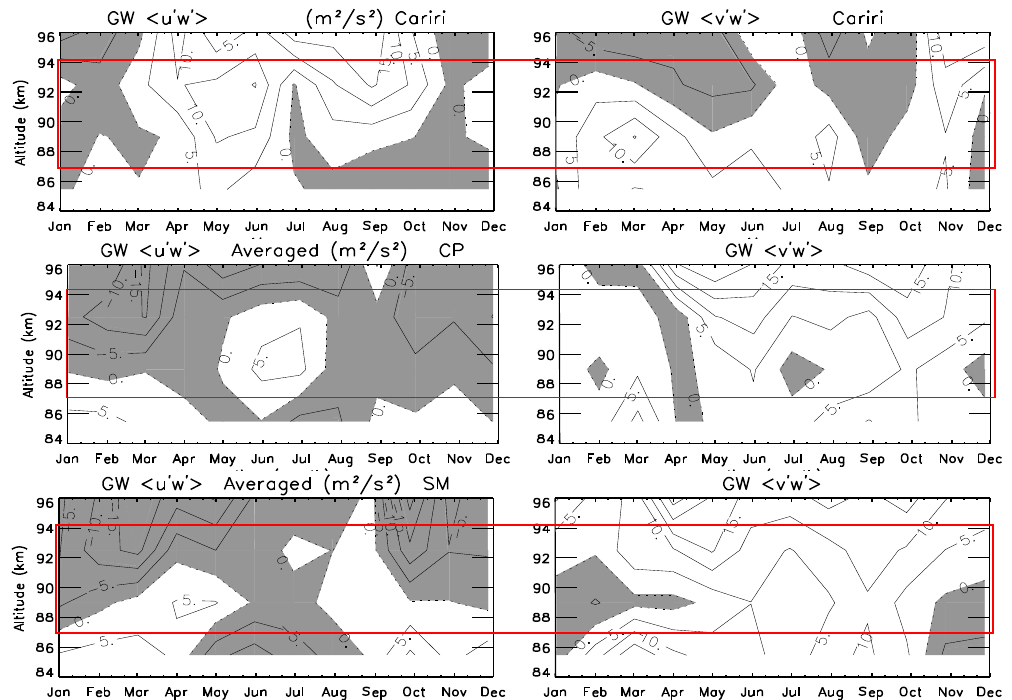
Figure 6. Averaged momentum fluxes throughout the entire available data series. Mean behavior of the vertical flux of horizontal momentum: zonal (left) and meridional (right) components. Each contour corresponds to 5m 2 s − 2 . The white areas represent positive values and grey the negative. The top panels are the results for São João do Cariri (Cariri, low latitude), the center panels are for Cachoeira Paulista (CP, mid-low latitude), and the bottom are for Santa Maria (SM, middle